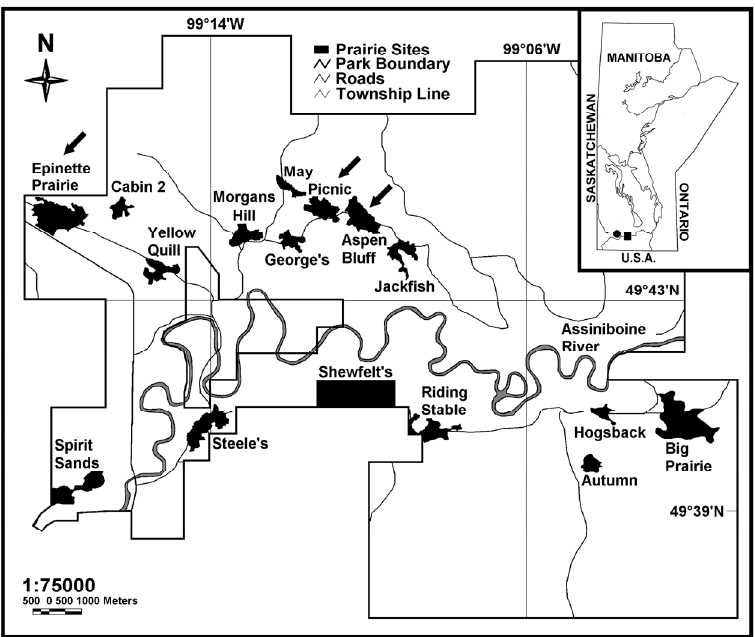
Figure 1. Regional setting of the Spruce Woods Provincial Park (SWPP) ( ■ ) and the Brandon Agriculture Station ( ● ) in southwestern Manitoba and a map of the SWPP. Adapted from Schykulski and Moore [36].